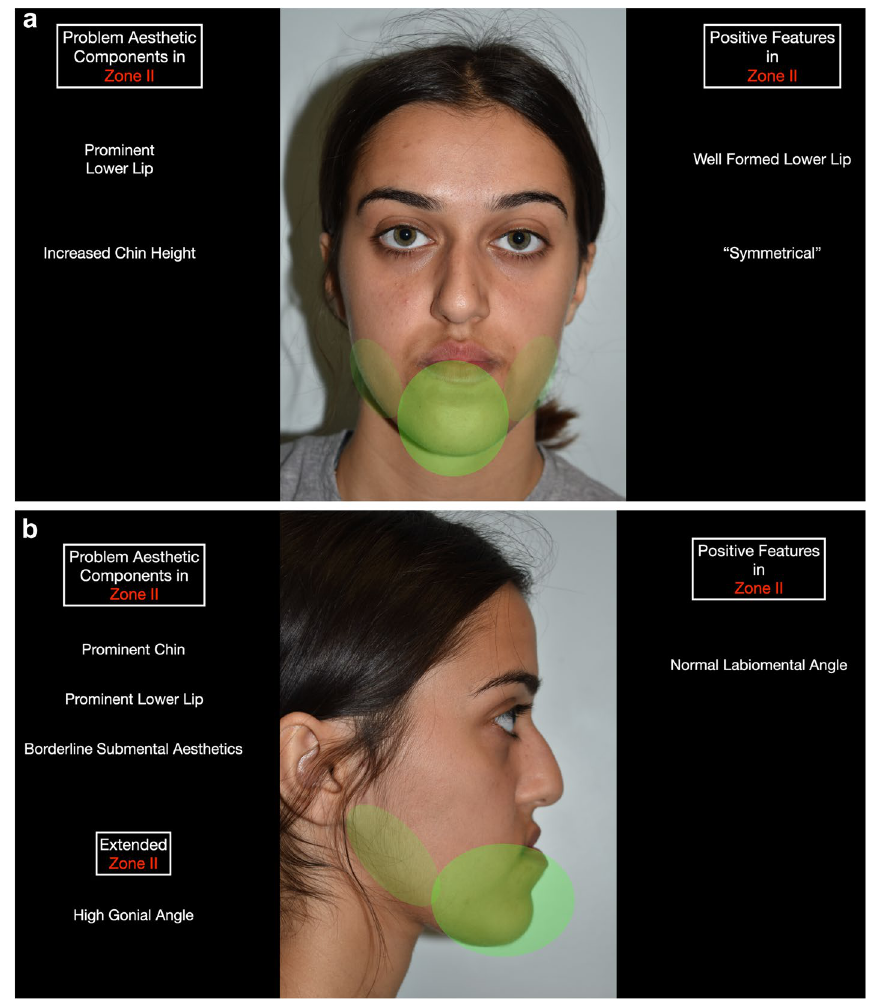
Fig. 3 a Zone II (mandibular zone), which includes the anterior mandibular dentition, lower lip, labiomental fold and chin. The extended zones include the inferior borders of the mandible and gonial angles. b Zone II in profile